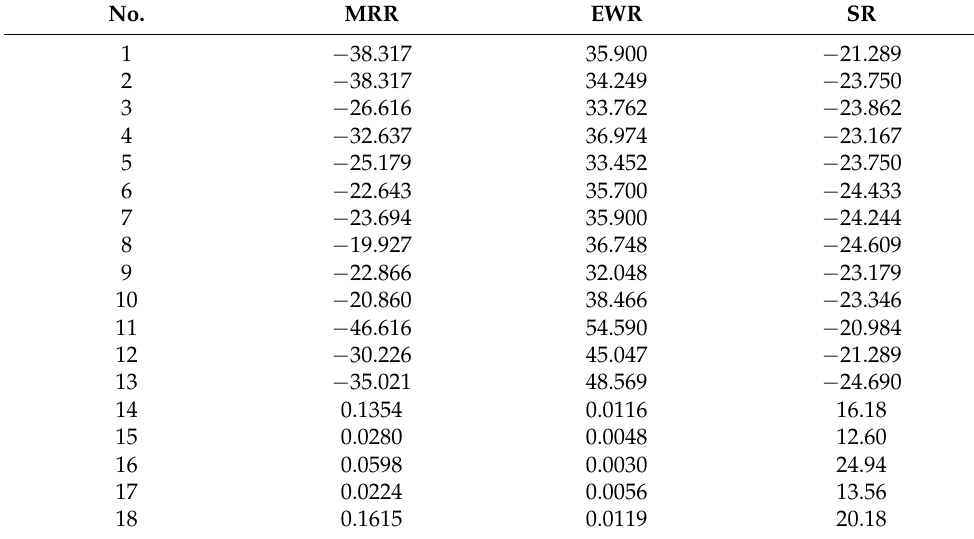
Table 8. S/N ratio ( η ) of EWR, SR, and